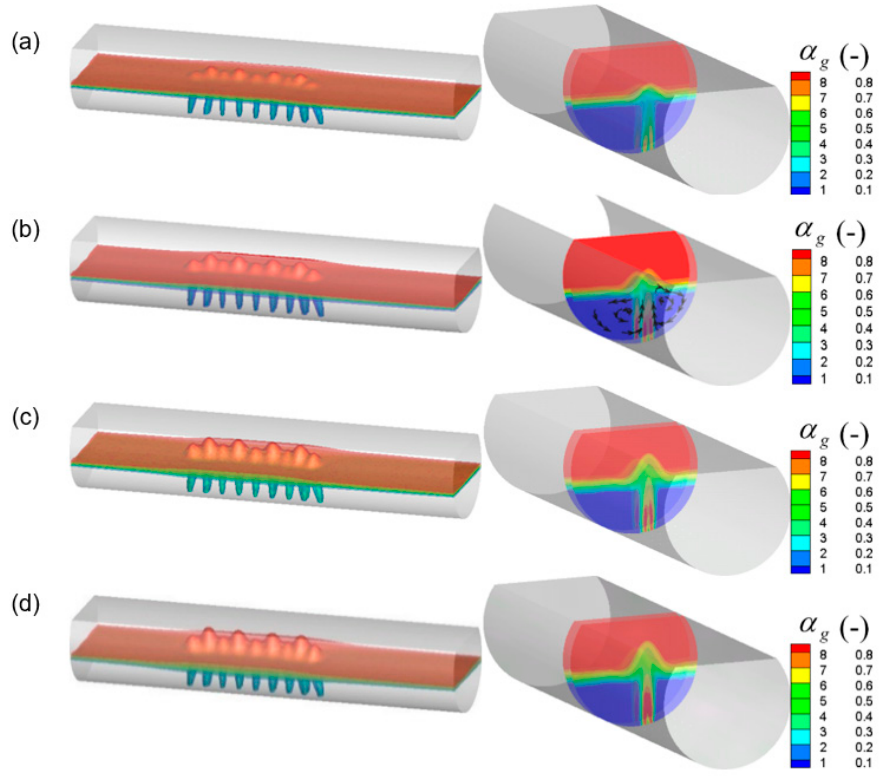
Figure 15. Predicted local gas volume fraction in the bath with different gas flow rates, which are ( a ) 4.7 m 3 /h, ( b ) 9.4 m 3 /h, ( c ) 14.1 m 3 /h, and ( d ) 18.8 m 3 /h, respectively.